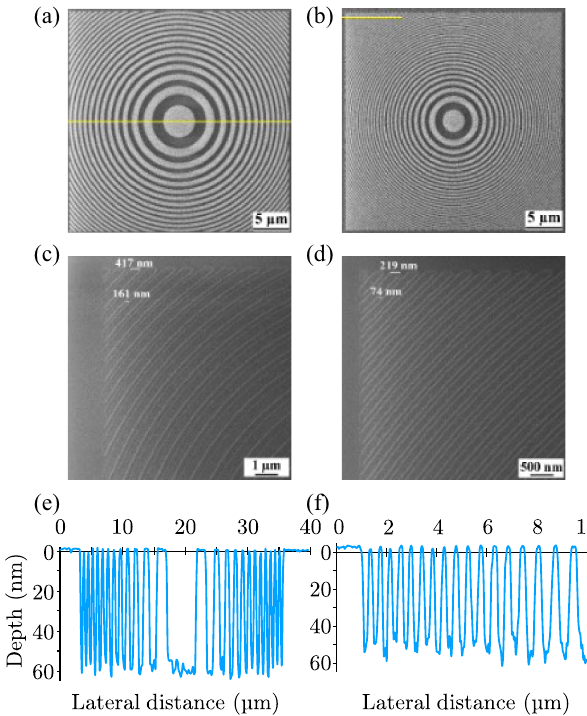
FIG. 7. (a),(b) HIM images taken with an electron flood gun of 30 × 30 μ m 2 zone plates of 0.18 and 0.35 NA, respectively, etched into MgO. (c),(d) High-magnification HIM images ac- quired at the top left corner of the 0.18- and 0.35-NA zone plates, respectively, with measured features labeled in white. (e) AFM linescan through the middle of the 0.18-NA zone plate [yellow trace in (a)] showing a depth of 60 nm. (f) AFM line scan of the top left corner of the 0.35-NA zone plate where the structures are densest [yellow trace in (b)], showing an etch depth of 60 nm for both. These structures are transferred from a PMMA mask by wet etching in 10% (v = v) H 3 PO 4 in